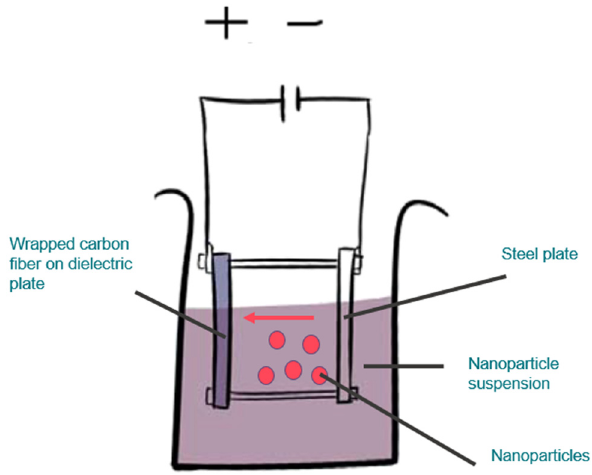
Figure 4: Schematic drawing of a custom - made cell used for elec - trophoretic deposition of nanoparticles onto carbon fi bers.